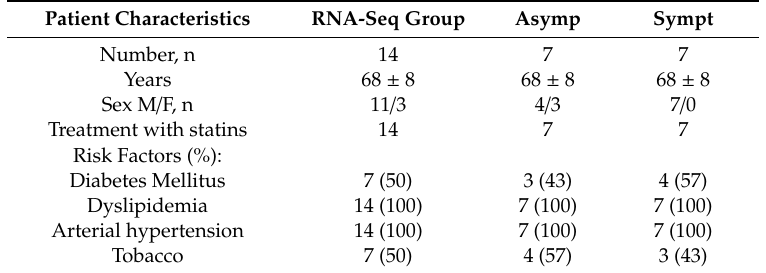
Table A1. Clinical and demographic patient data from the Biocruces Bizkaia cohort samples. Samples used for SNP identification by RNA-Seq [20].